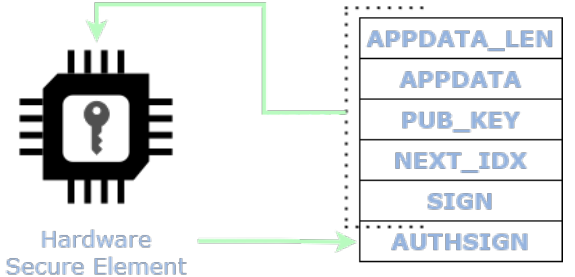
Figure 6. L2Sec message with Authentication Signature generated by a Hardware Secure